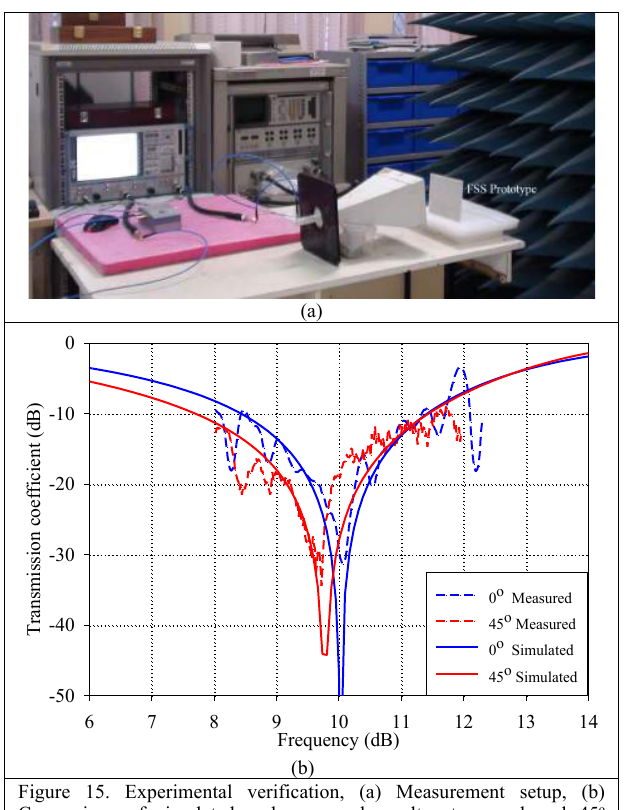
(b) Figure 15. Experimental verification, (a) Measurement setup, (b) Comparison of simulated and measured results at normal and 45 o incidence